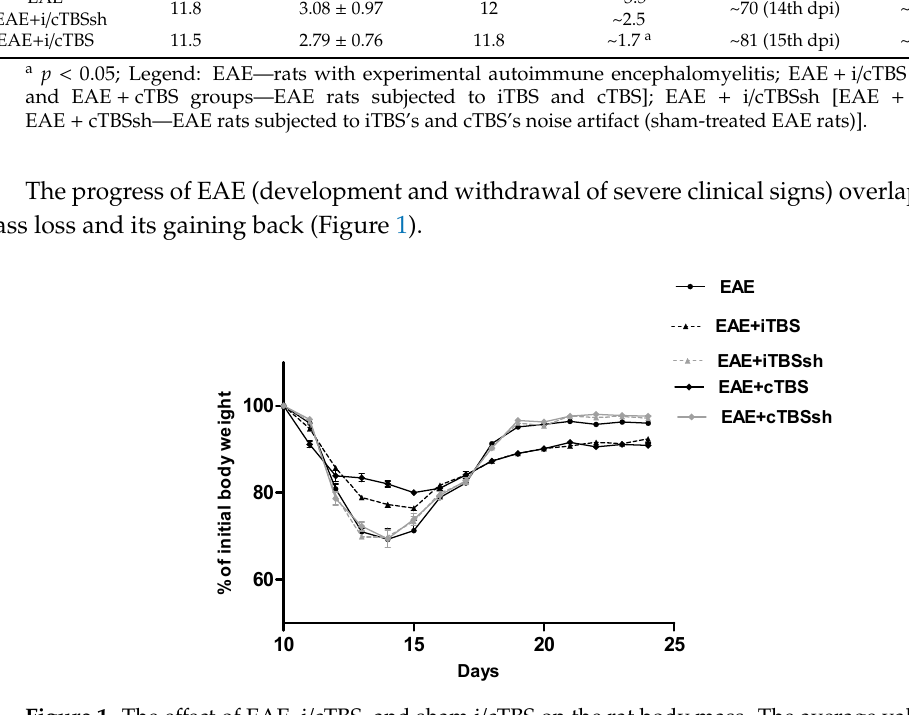
Table 1. Alleviation of EAE clinical symptoms by iTBS and cTBS in rats.